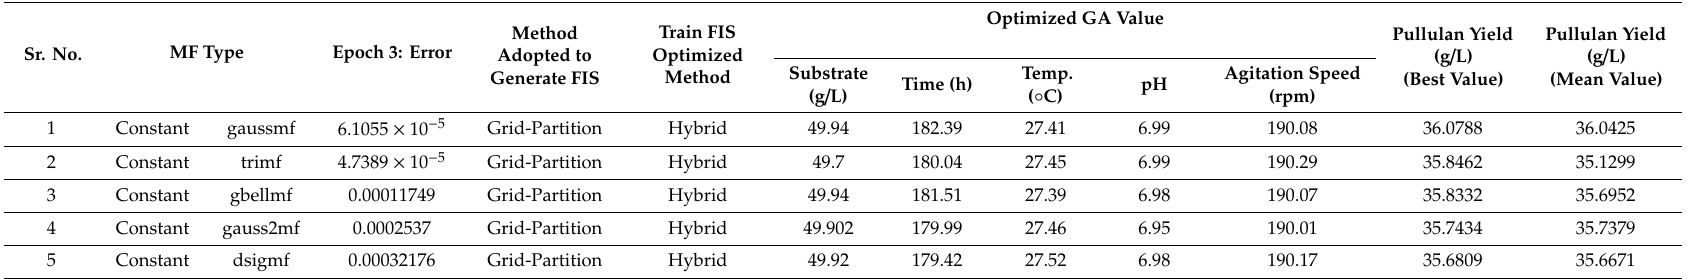
Table 3. Various chosen ANFIS training membership functions (MFs) and resultant optimized GA process parameters (epoch error, best value, and mean value for pullulan yield) and their respective yields.